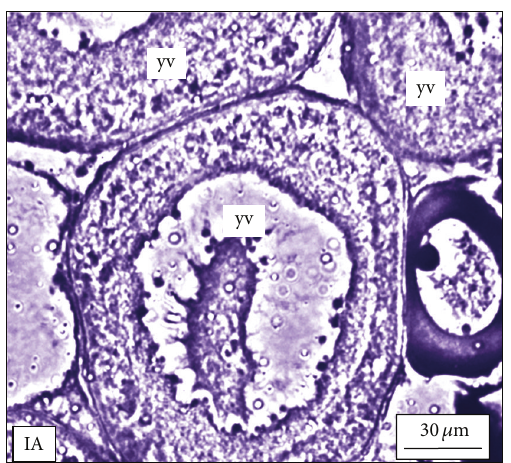
Figure8:Thehistologicalsectionoftheovaryofa M.tengara during theearlyspawningphase(June)showinganapoptoticmaturefollicle (mf) bearing conspicuous pycnotic nuclei (white arrows) of the zona granulosa layer and intact theca layer (th) when the tissues are treated with ZnS nanoparticles at the concentration of 250 𝜇 g/L [Mallory’s triple stain].